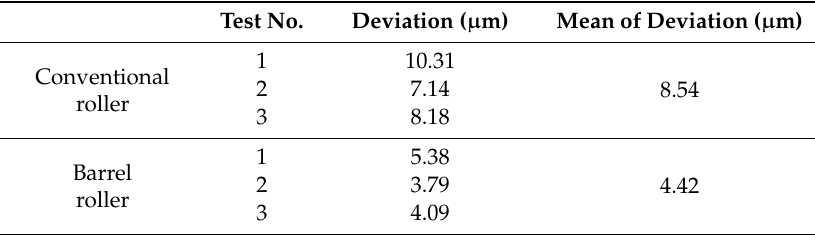
Figure 16. Comparison between relative displacements of conventional and optimized barrel rollers. The laser pattern number is an index in Figure 14. The spacing between the laser pattern numbers is 10 mm. Table 8. Deviation of relative displacement in each experiment: Conventional versus optimized barrel